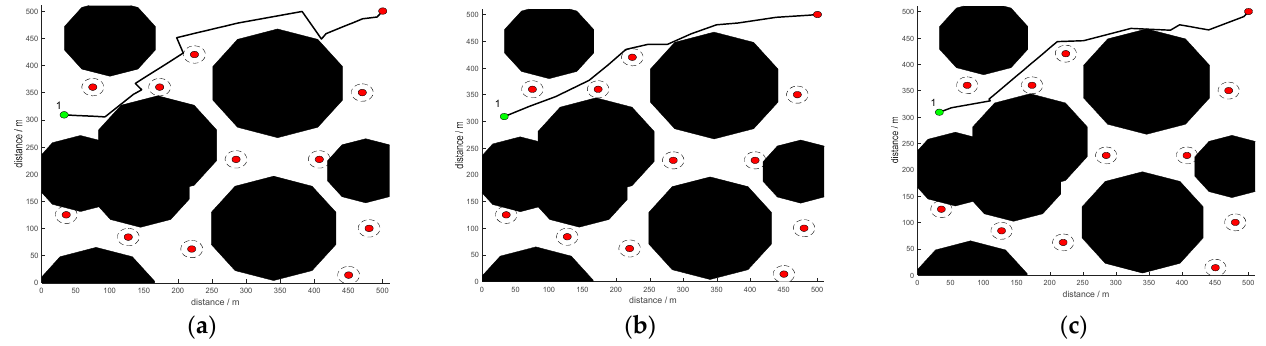
Figure 18. The path results of each algorithm for vehicle No. 1 under Map No. 1. ( a ) is the path result of RRT-connect; ( b ) is the path result of RRT*; ( c ) is the path result of dual RRT optimization.